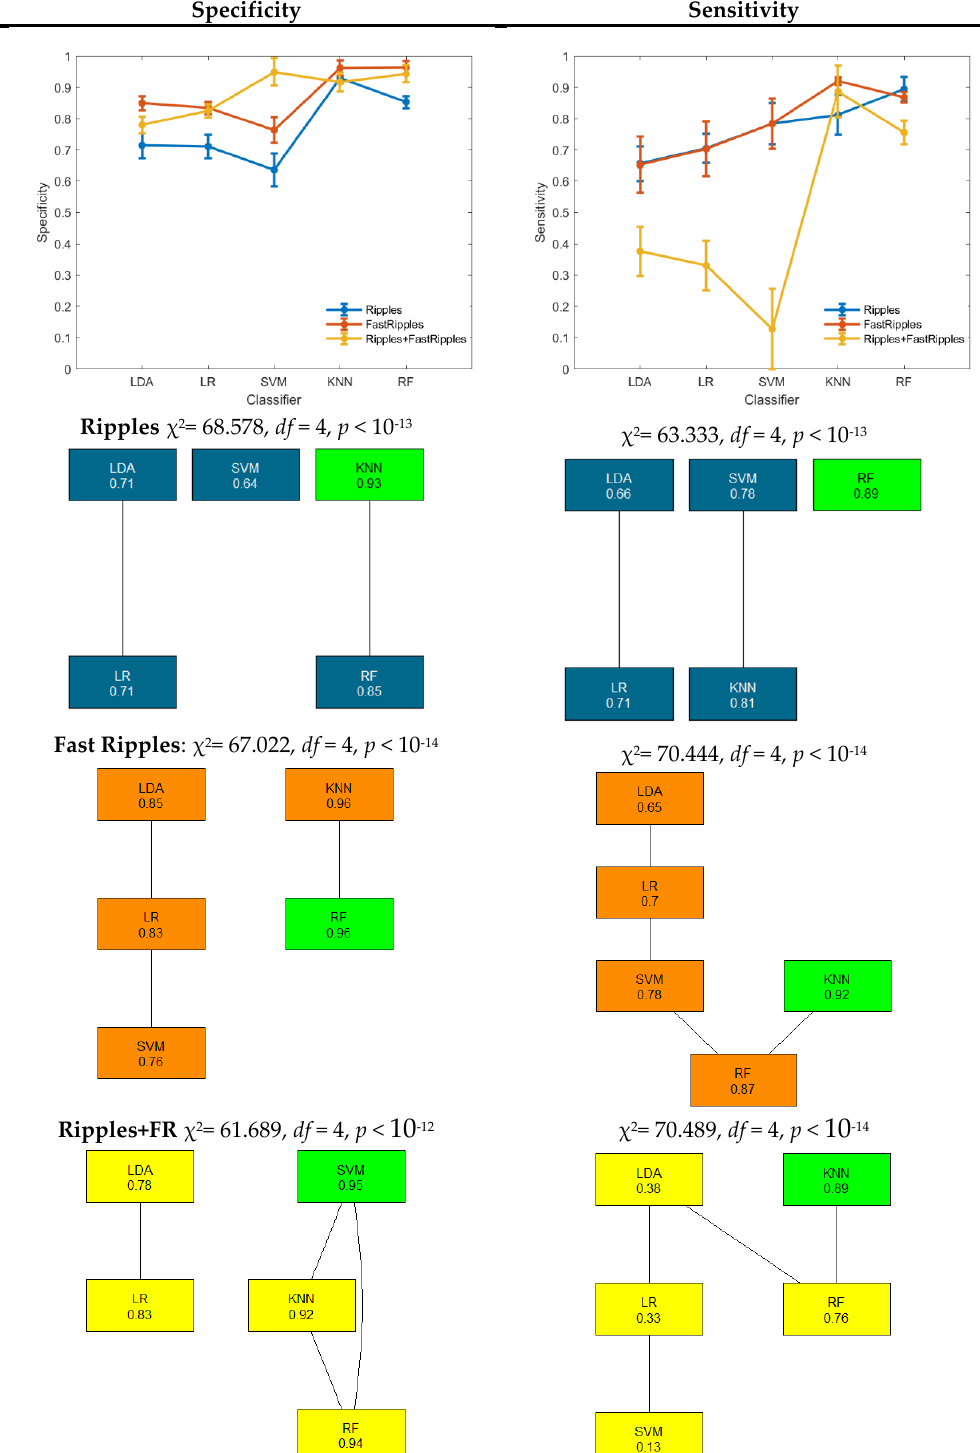
Figure 3. Three-class classification performance in terms of specificity and sensitivity for each class. The results of the Friedman test have been reported above the Bergmann and Hommel’s procedure graph.